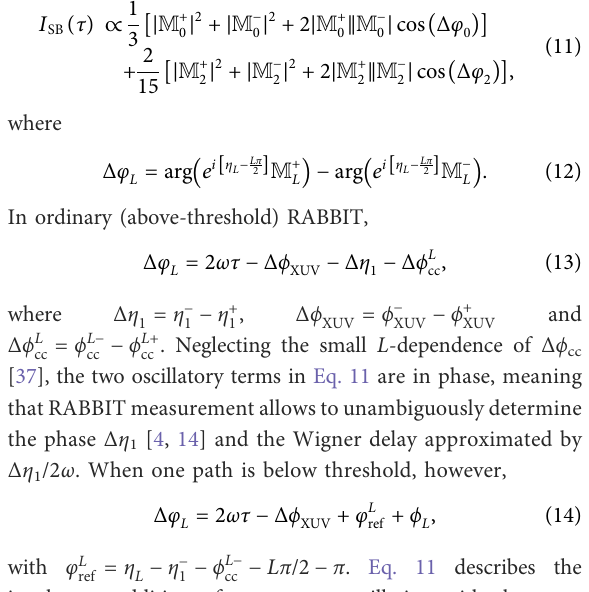
FIGURE 4 (A) Phase η L − L π /2 (blue) and ϕ L − energy for L = 0 (solid) and L = 2 (dashed); (B) Reference phase φ